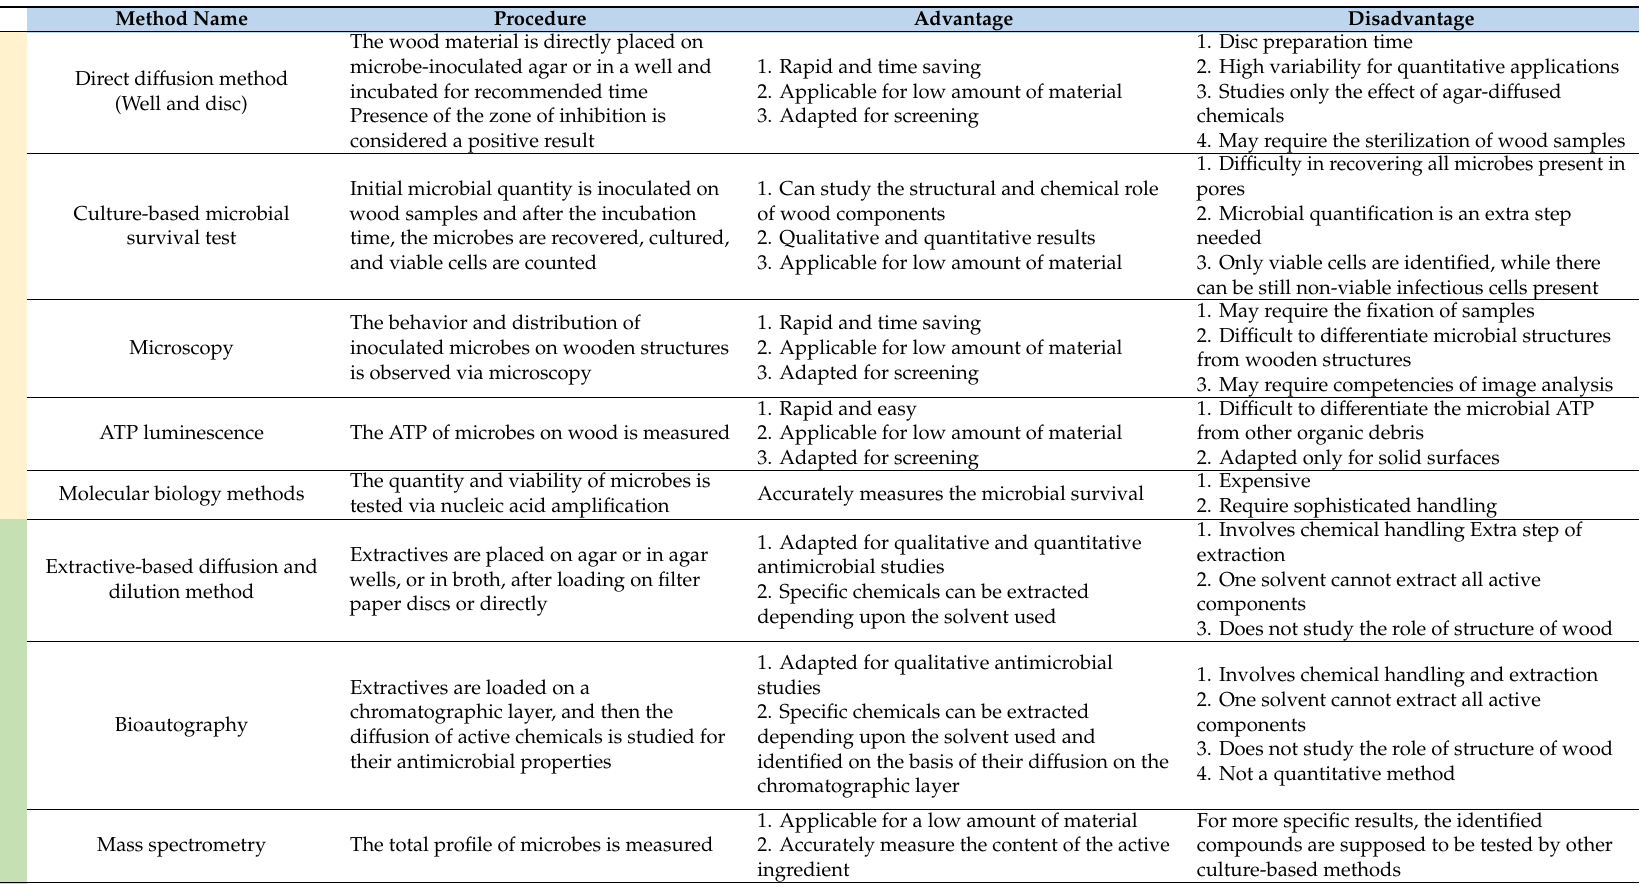
Table 2. Pros and cons of the methods used to study the antimicrobial behavior of wood